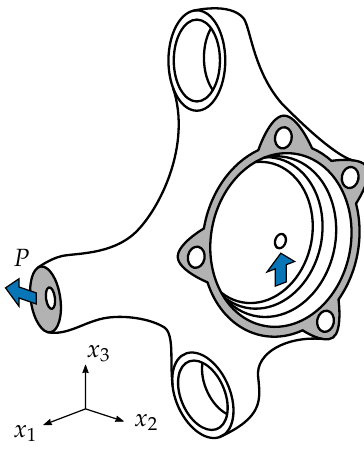
Figure 7. Illustration of the used knuckle. The kinematic hard point P for the connection to the track rod is located in the center of the gray area on the left side. The large gray area on the right represents the connection to the wheel